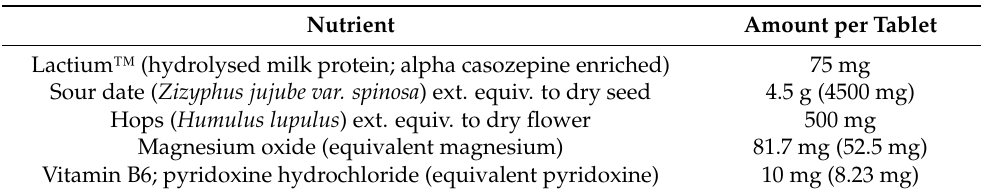
Table 1. LZComplex3 components.